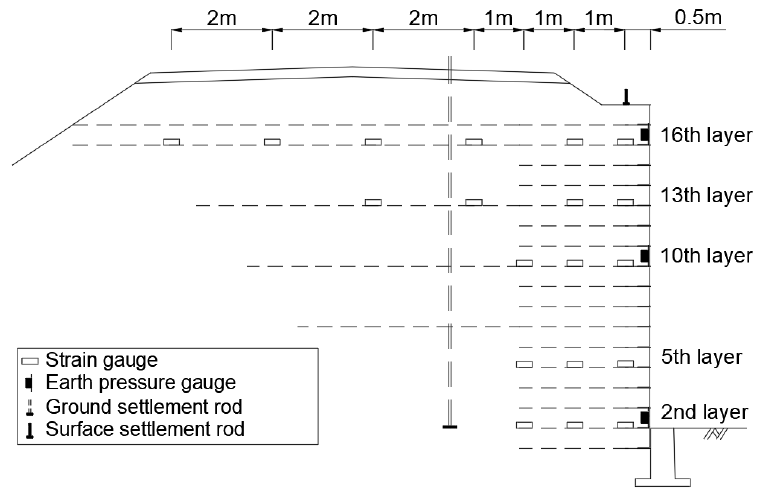
Figure 5. Location of installed sensors .